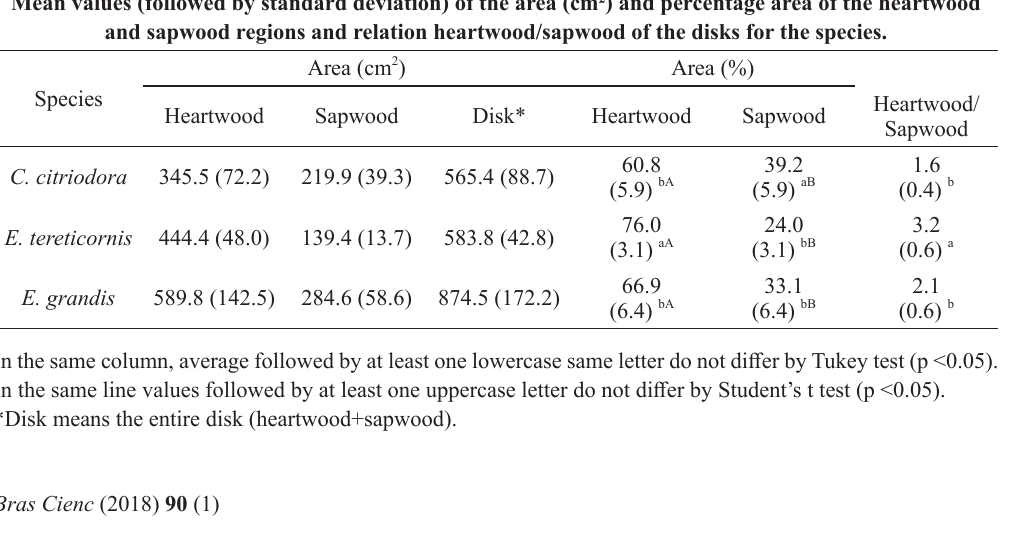
Mean values (followed by standard deviation) of the area (cm²) and percentage area of the heartwood and sapwood regions and relation heartwood/sapwood of the disks for the species. Area (cm 2 ) Area (%) Species